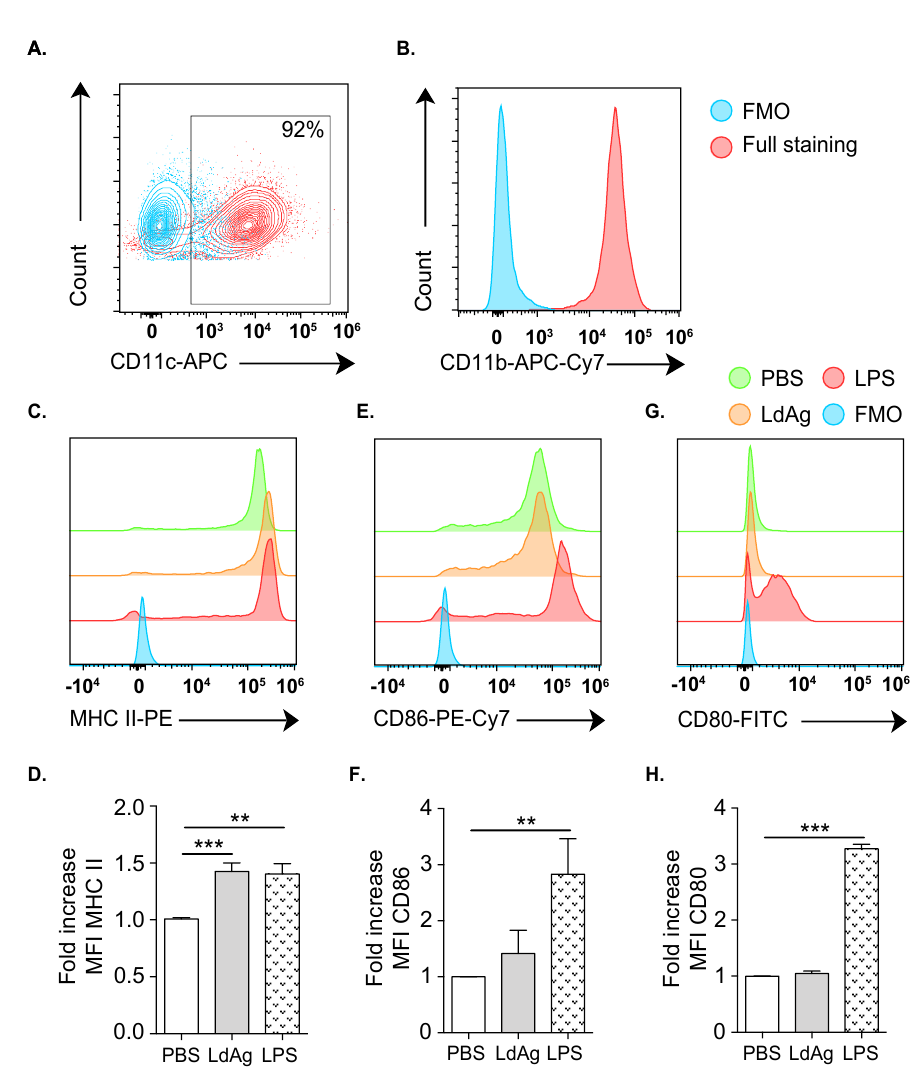
Fig 1. LdAg induce MHC II expression in BMDCs. (A, B) Representative flow cytometry plots showing the expression of CD11c (A) and CD11b (B) on BMDCs. (C-H) Representative flow cytometry plots showing the expression of MHC II (C), CD86 (E) and CD80 (G). Corresponding quantification are presented as mean fluorescence intensity (MFI) fold increase, calculated as the ratio between LdAg- or LPS-stimulated BMDCs compared to untreated (PBS) BMDCs (D, F, H). Data are representative of at least two independent experiments and are presented as means ± SEM ( n = 4; one-way